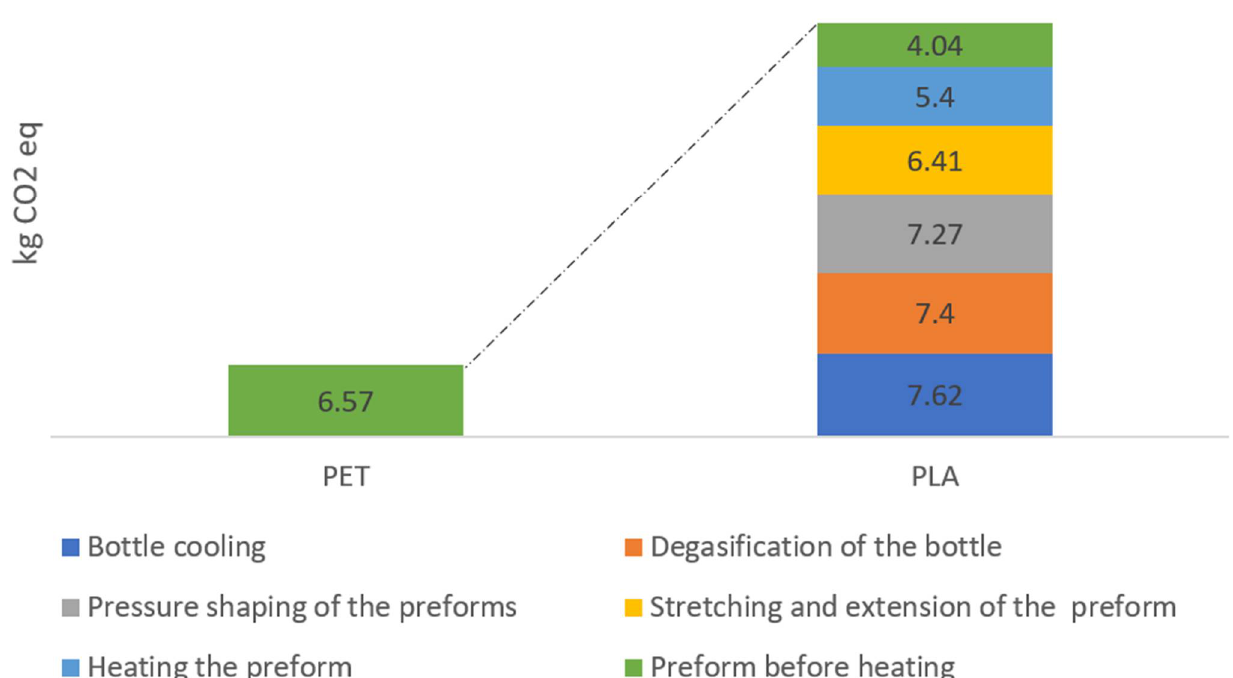
Figure 6. Global warming emissions throughout the entire bottle shaping process.